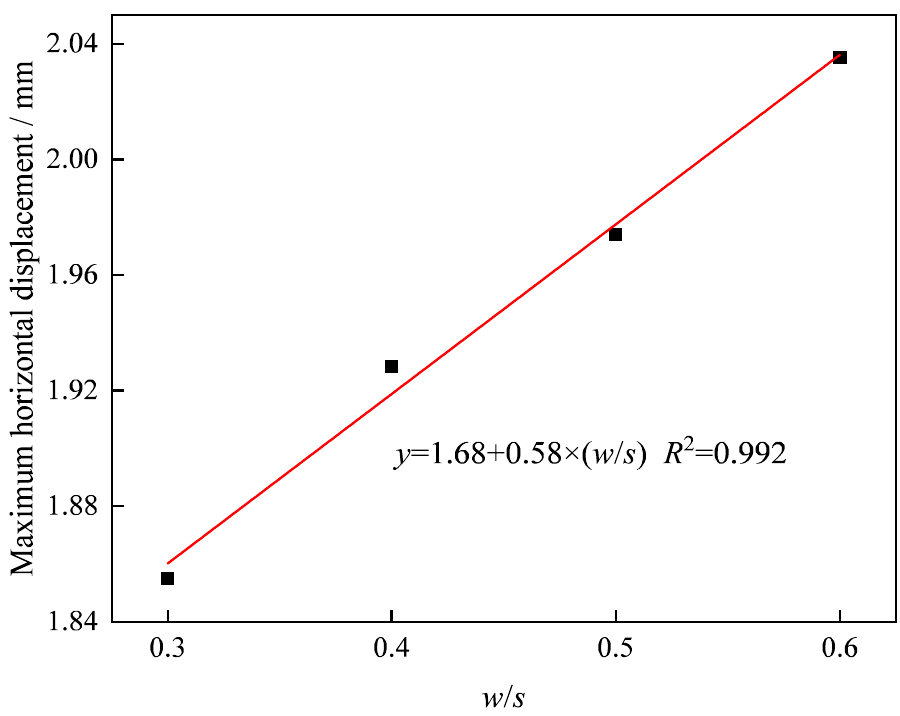
Figure 25. Horizontal displacement curve of the side wall.